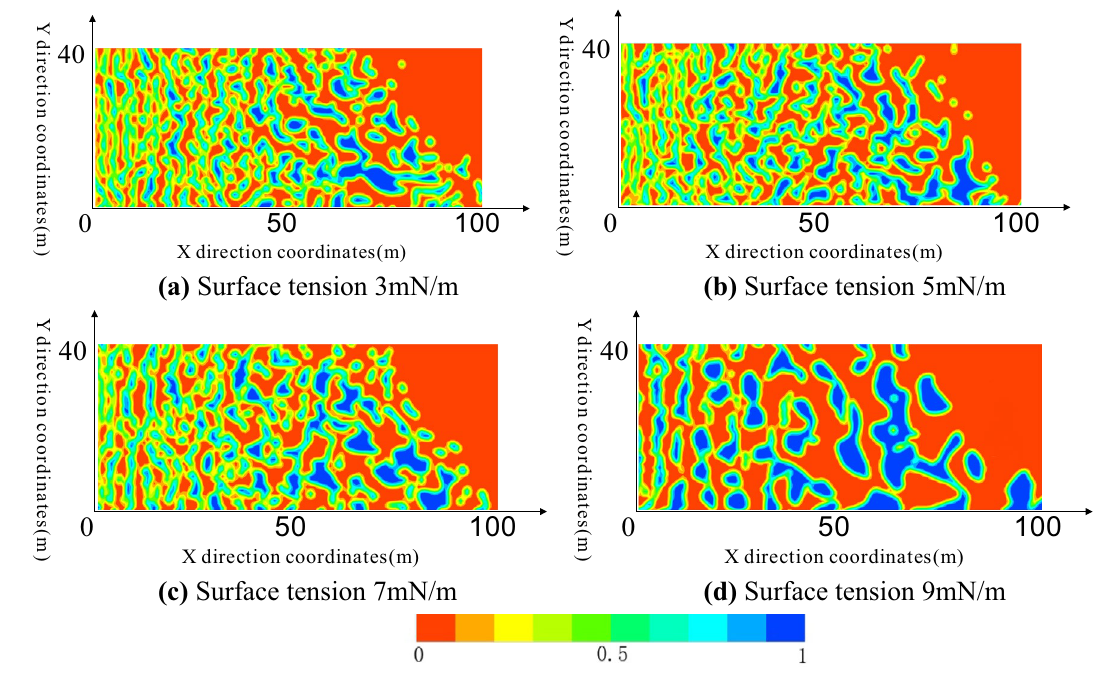
Fig. 8 Volume fractions of the self-propping fracturing liquid at different surface tensions